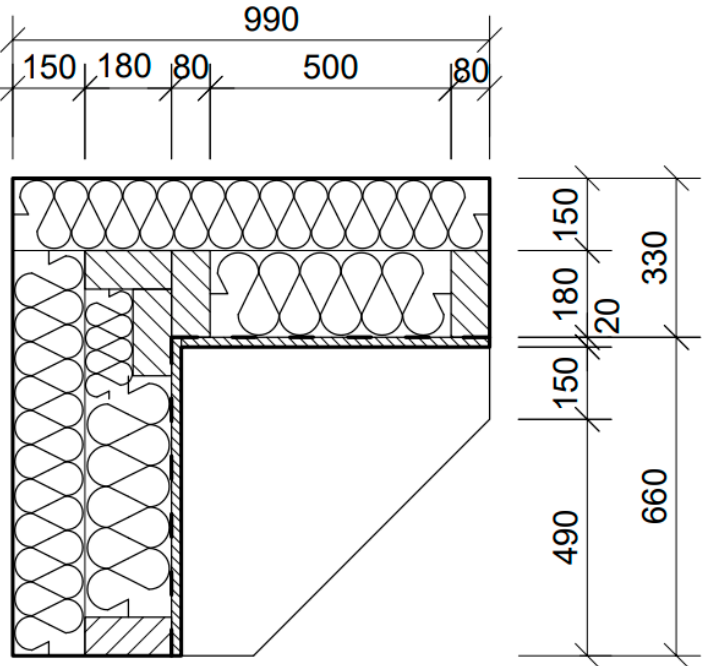
Figure 3. Timber-based specimen of an exterior corner.